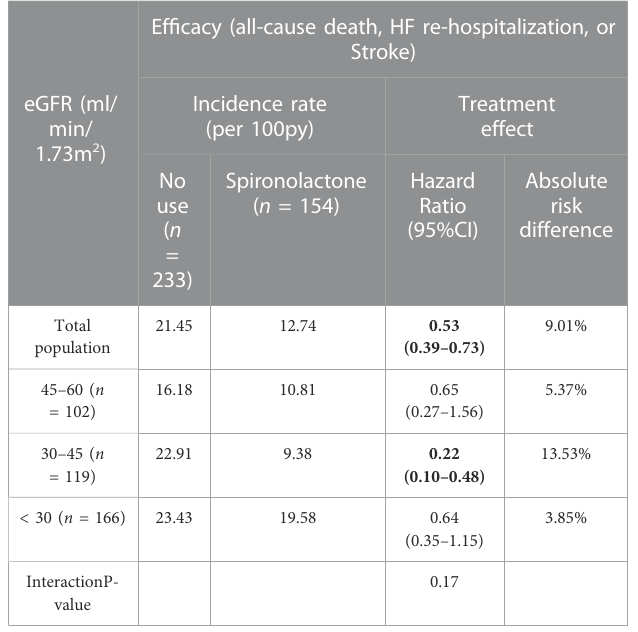
TABLE 7 Impact of spironolactone on clinical outcomes by estimated glomerular fi ltration rate (eGFR) category.